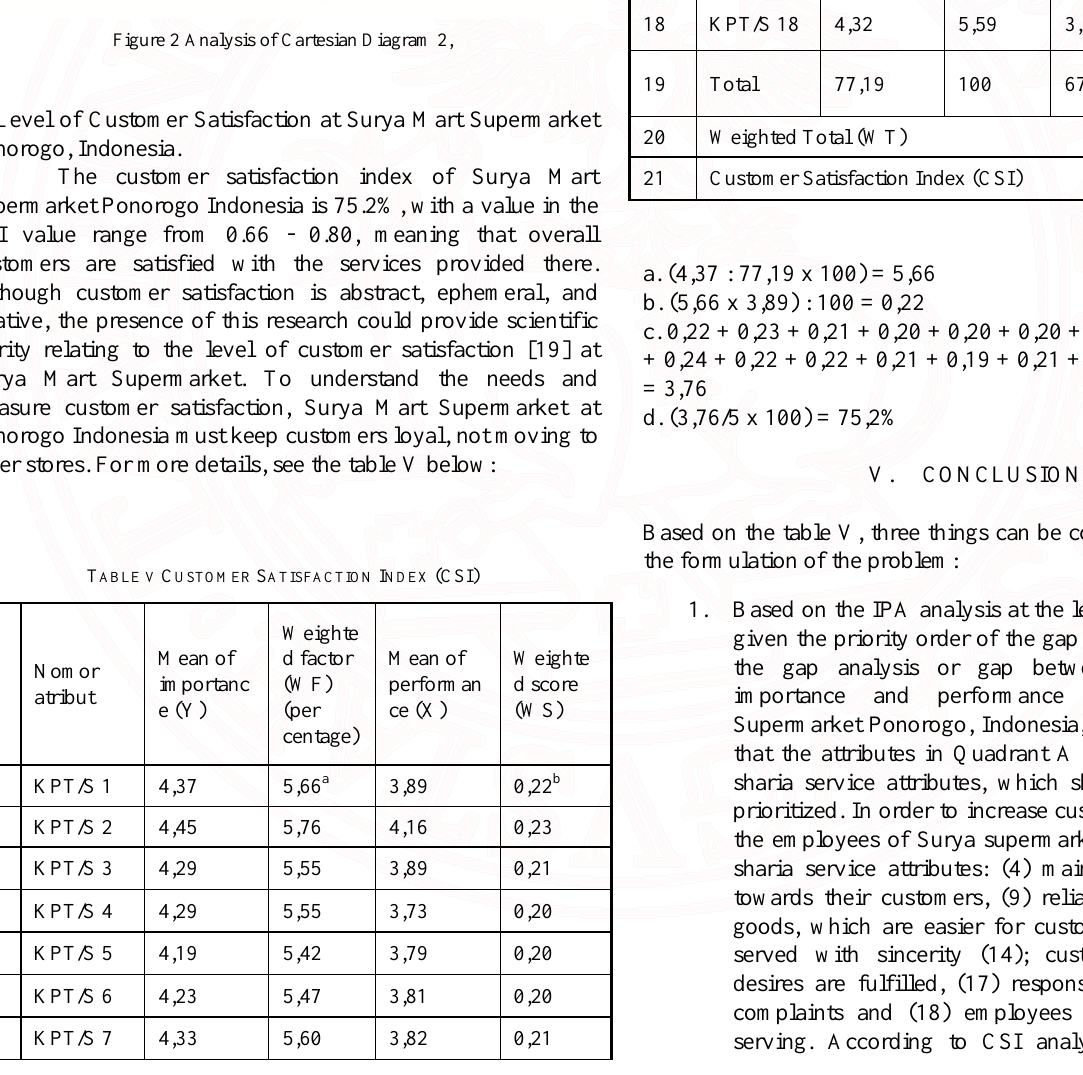
Figure 2 Analysis of Cartesian Diagram 2,